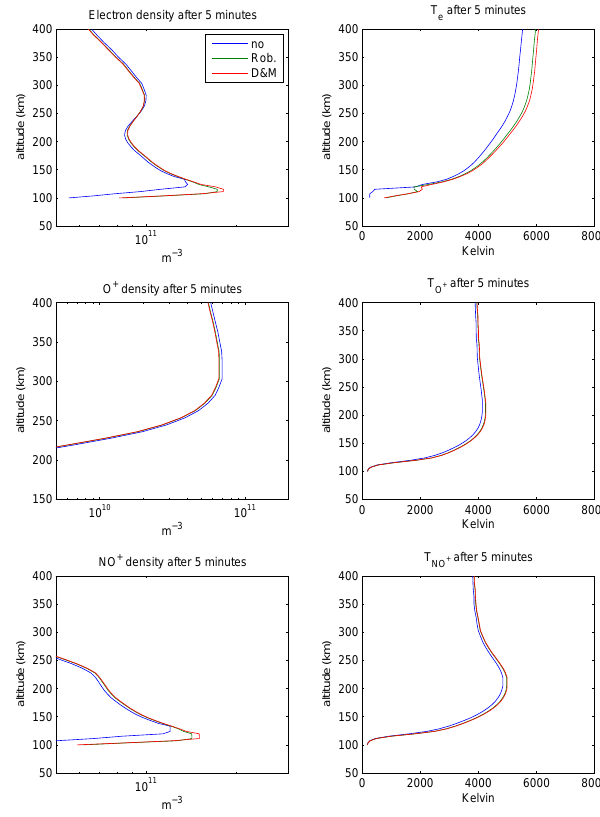
Fig. 12. Density and temperature profiles 5 min after the introduc- tion of an electric field and of precipitation, taken just on the edge of the arc, in the region of large parallel current